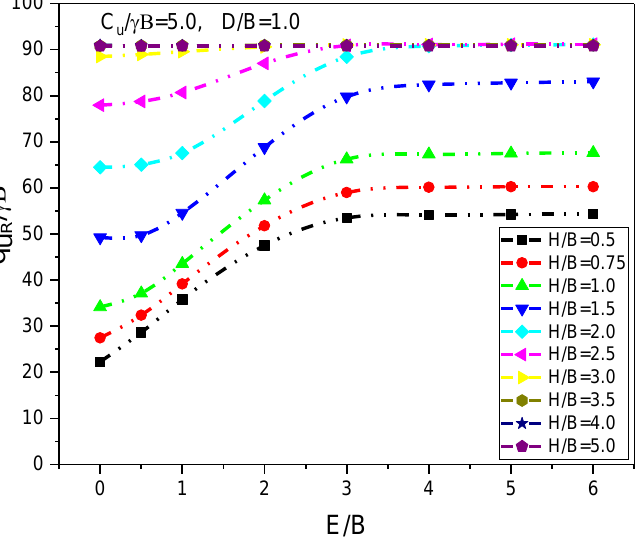
Figure 15. Effect of reinforcement on the ultimate bearing capacity ratio with a change in the horizontal distance of the void.